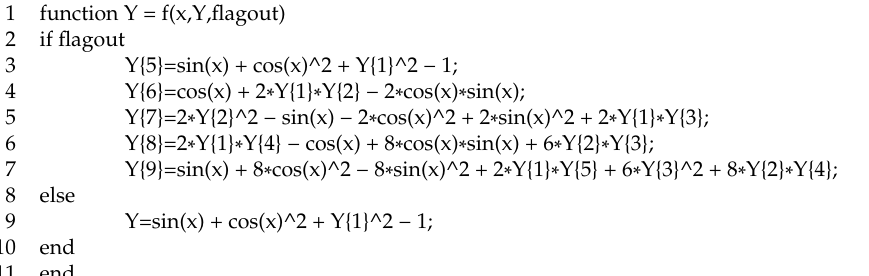
Figure 3. MATLAB function f.m generated by the code of Figure 2 for the problem given in Equation (31), using m 9 for the highest spline order. All relevant analytical derivatives have been set up automatically. =